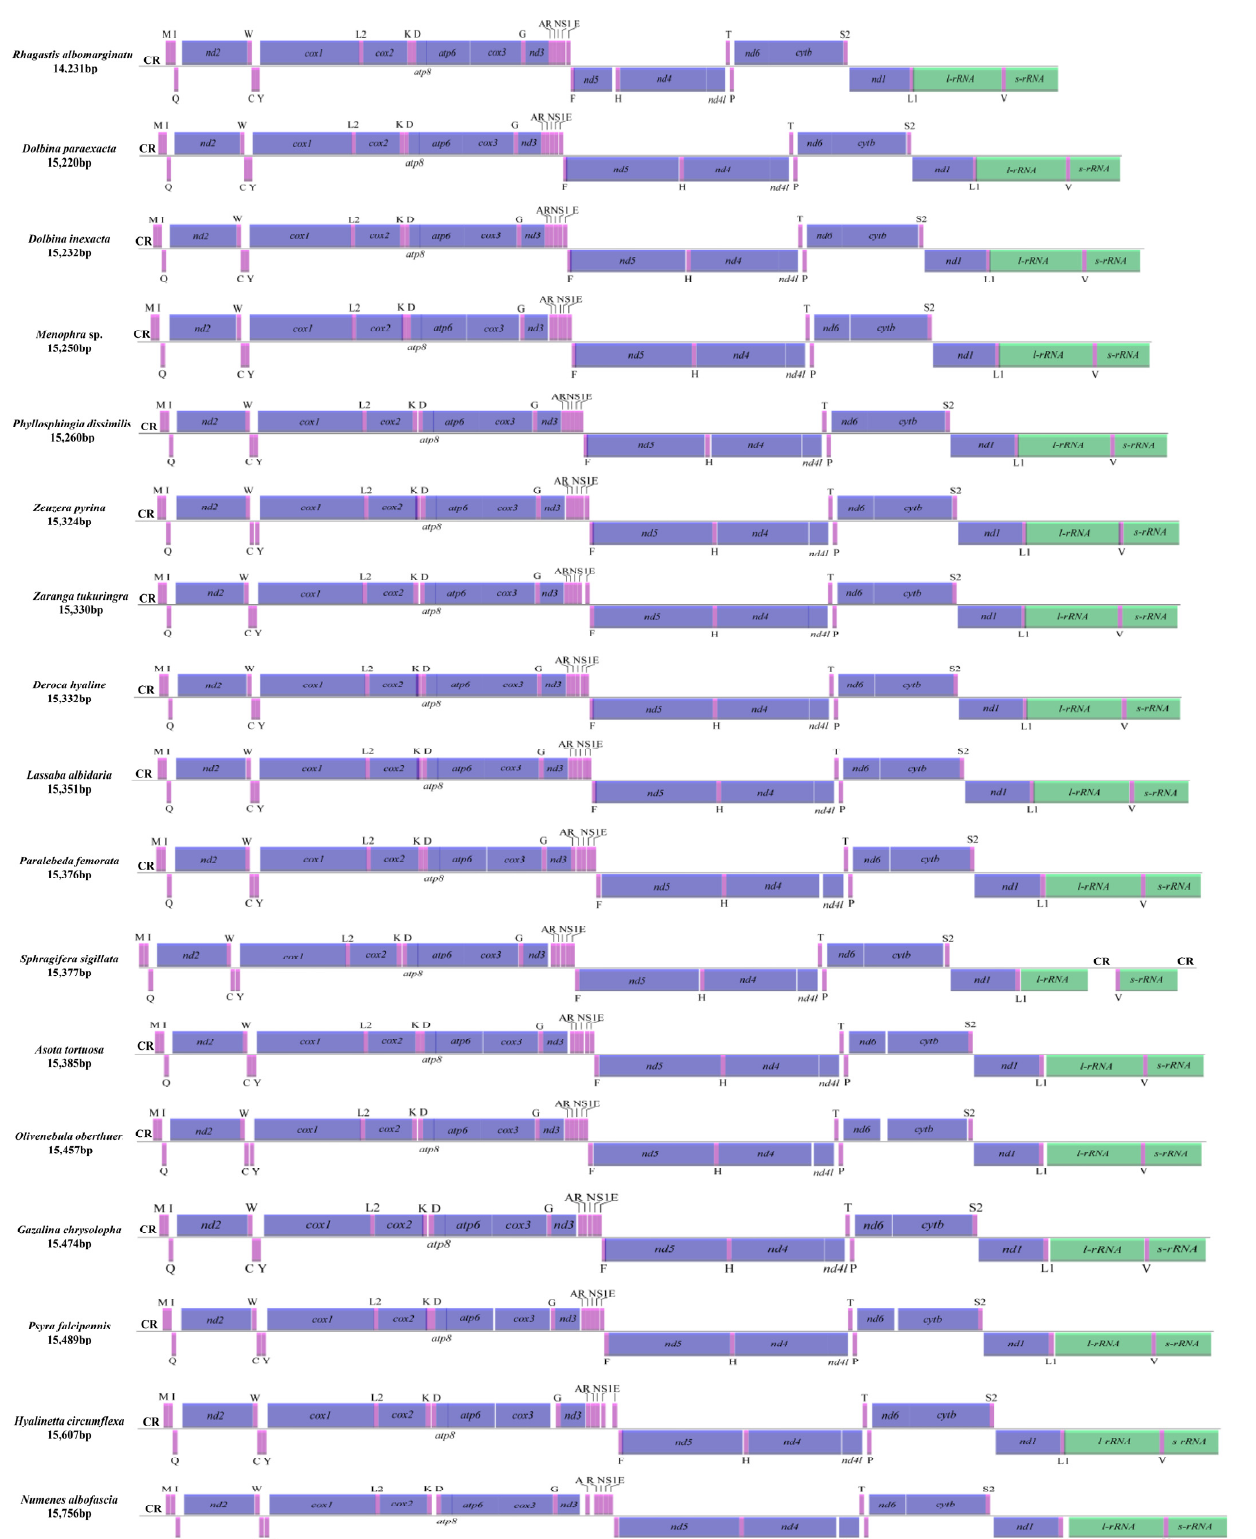
Figure 1. Linear map of the complete mitogenomes of 17 moths. CR, putative control region. Note: The nad5 in the mitogenome of R. albomarginatus may need further validation.